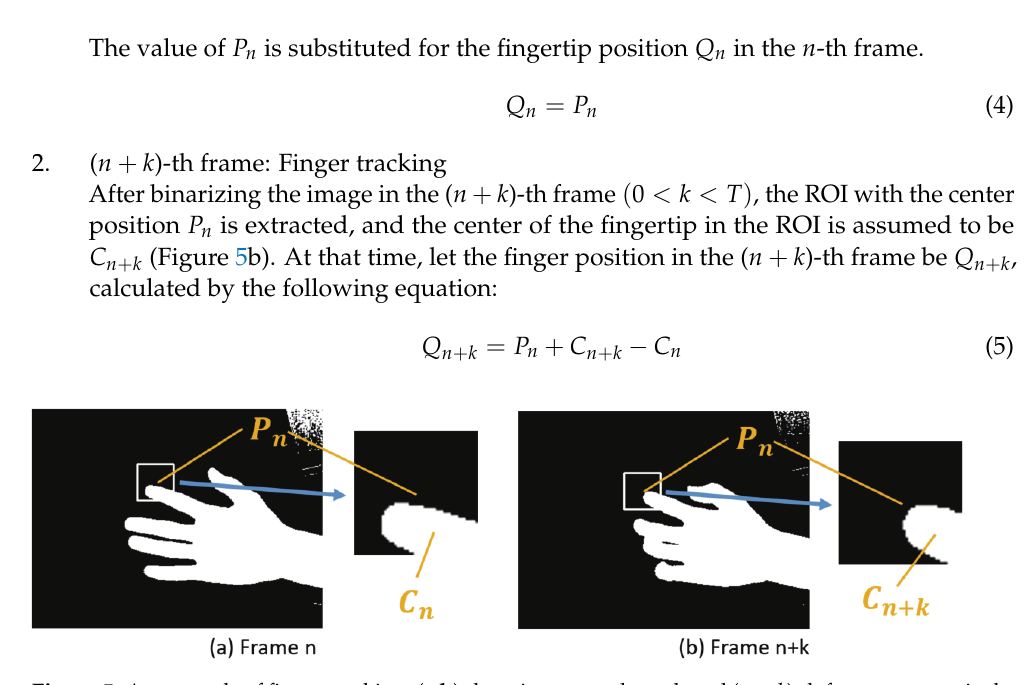
Figure 5. An example of finger tracking: ( a , b ) show images at the n -th and ( n + k )-th frames,